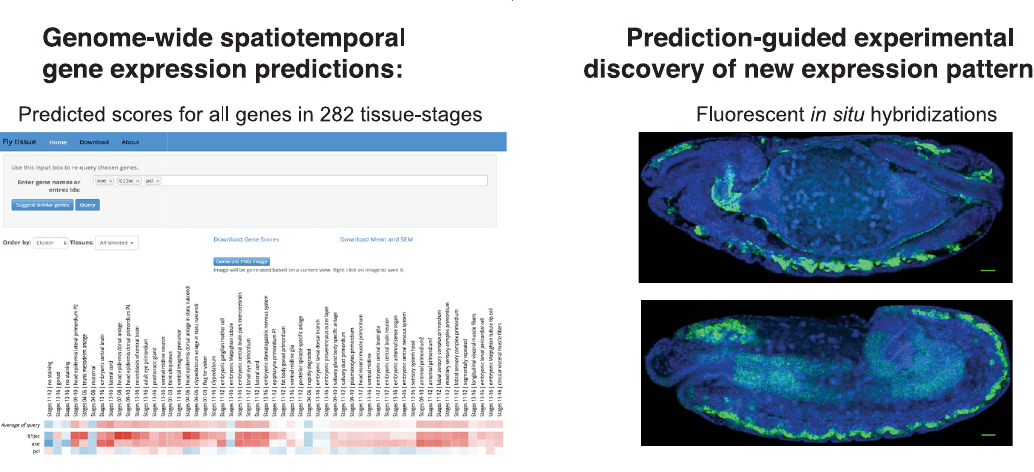
PLOS Genetics | https://doi.org/10.1371/journal.pgen.1008382 September 25, 2019 4 /